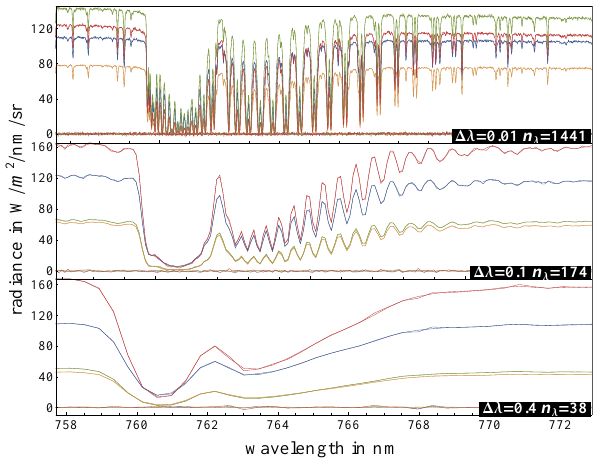
Figure 1. Random selection of synthetic spectra and inversion re- sults for spectral resolution and sampling of 0 . 01nm, 0 . 1nm, and 0 . 4nm. The synthetic signal to noise ratio was set to 100 (see Sect. 4 for a definition of the noise model), and the thin lines around the zero line show the fit